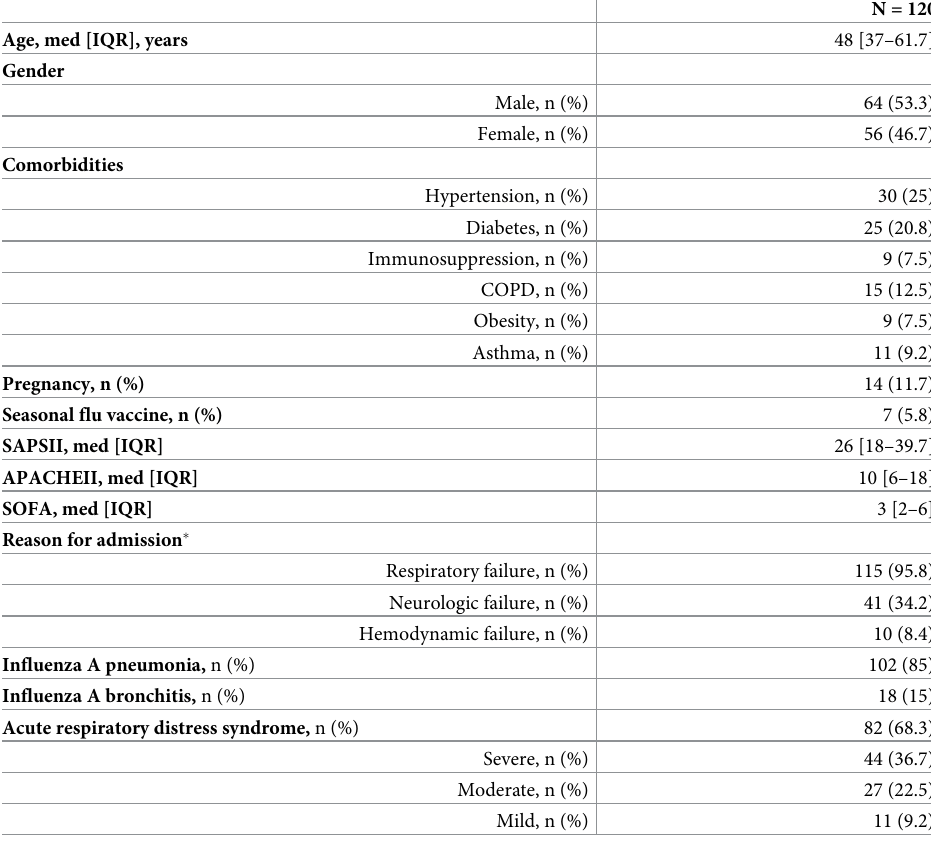
Table 1. Baseline characteristics and severity on ICU admission of 120 patients with influenza